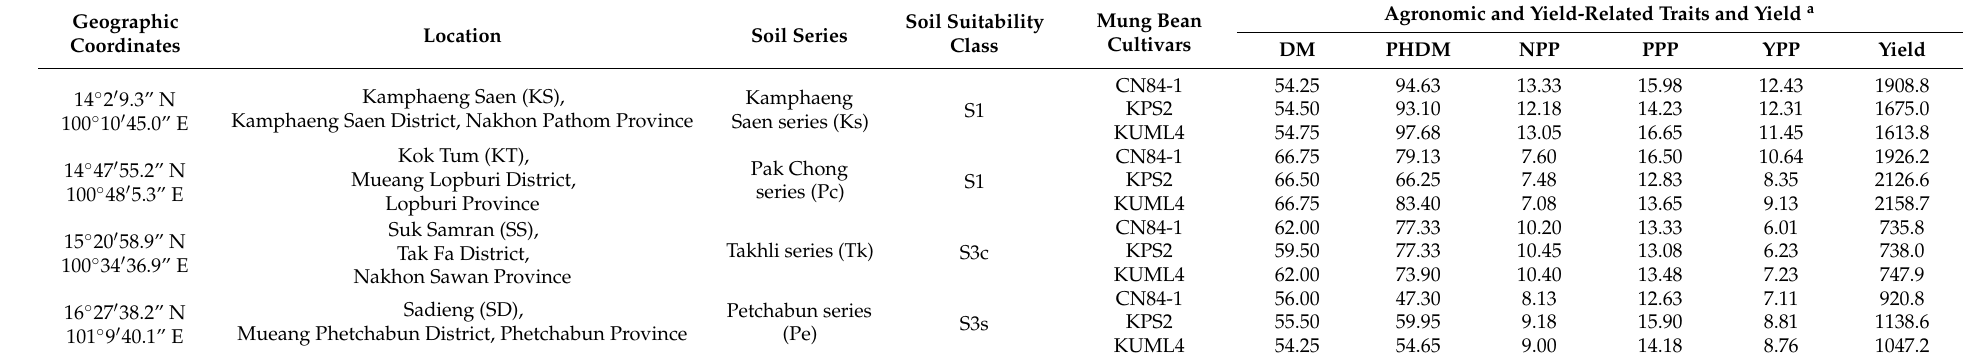
Table 4. Average values ( n = 40) of agronomic and yield-related traits and yield of three mung bean cultivars cultivated in the areas with different soil suitability classes in the rainy